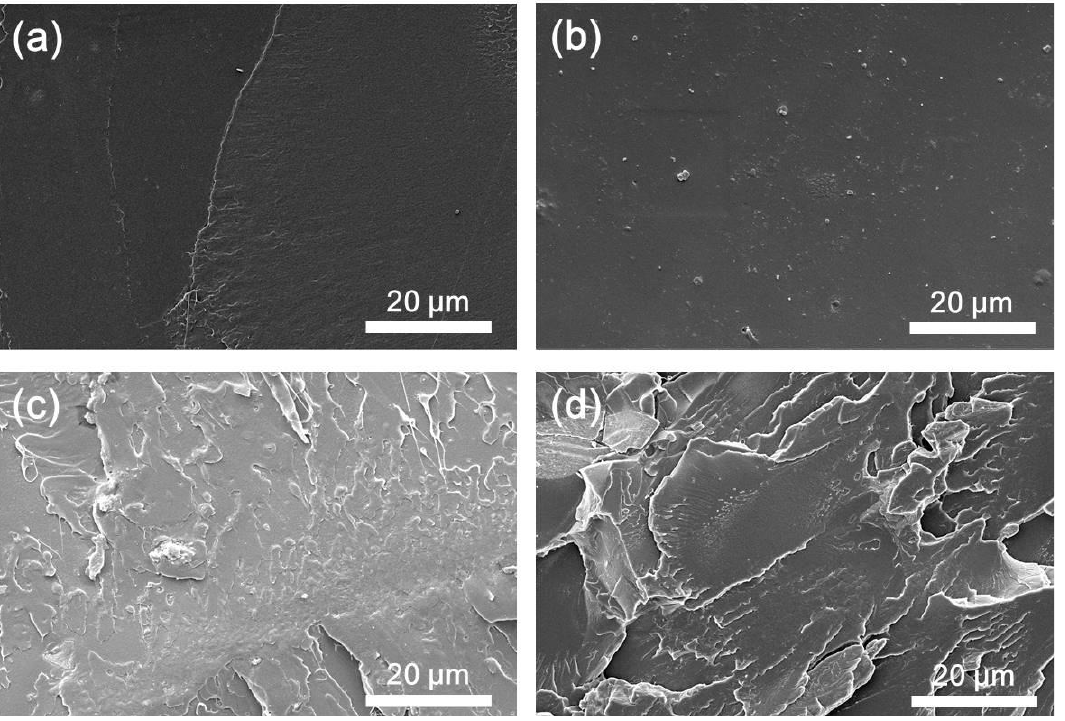
Figure 3. SEM images of the cryo-fracture surfaces of ( a ) pure PLA, ( b ) PLA/APP, ( c ) PLA/serpentine, and ( d ) PLA/serpentine@APP composites.